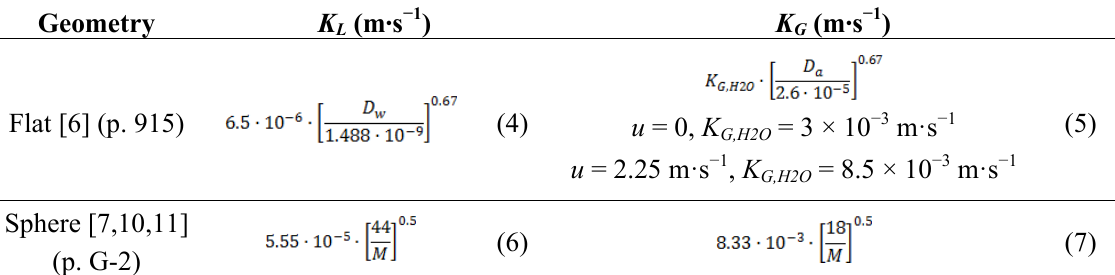
Table 1. K and K values (m∙s −1 ) for flat and spherical geometries. L G